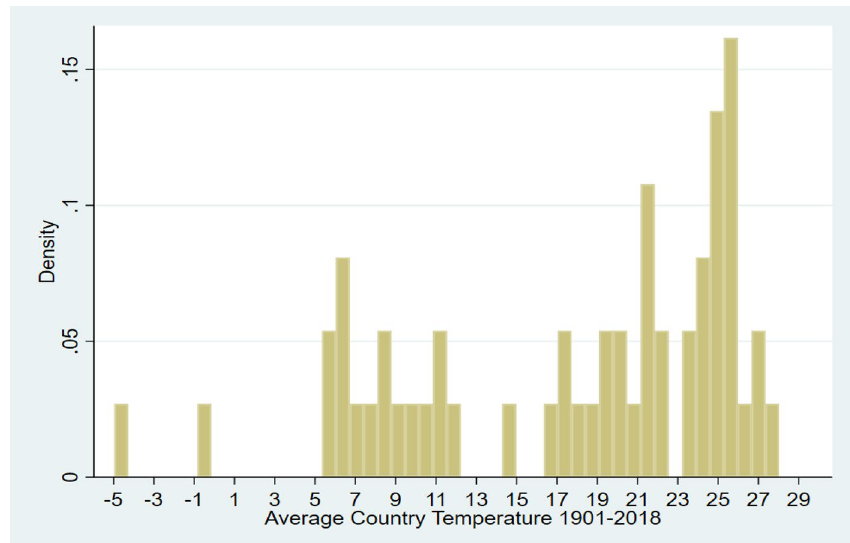
Fig. 3 Histogram of average temperature of every sample country. Source: Climatic Research